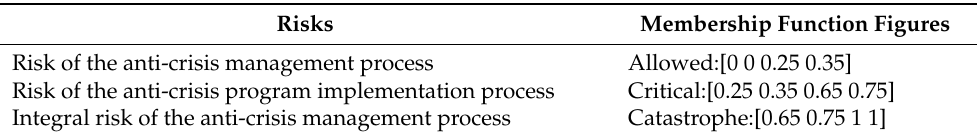
Table 3. Parameters of the membership functions for the evaluation of the integral risk of anti-crisis management (the authors’ development).